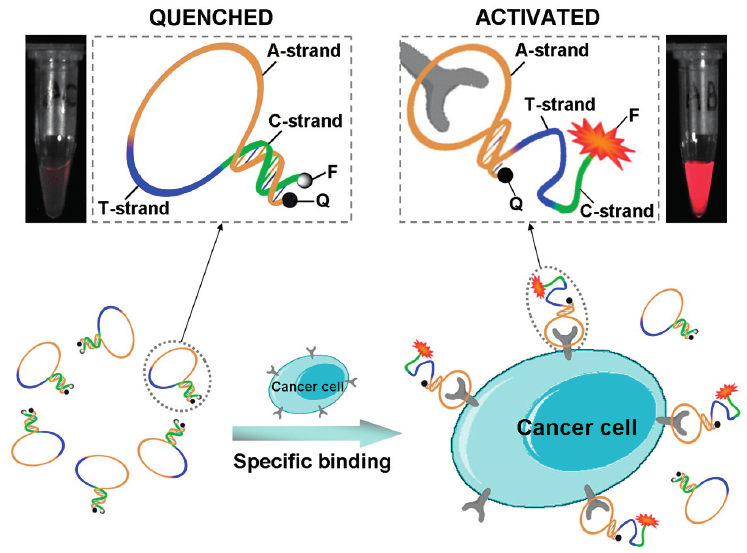
Figure 5. Schematic representation of the design of the activatable aptamers probe (AAP)